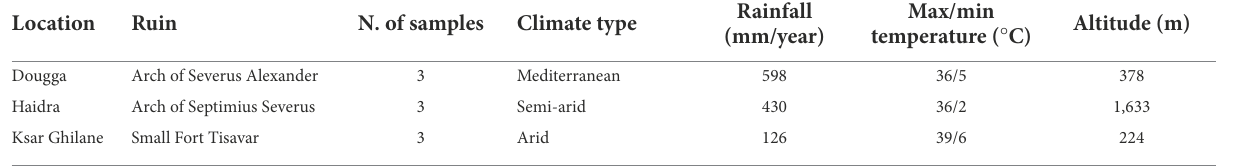
TABLE 1 Location and climate conditions of the three sampling sites in which stone ruins were collected.